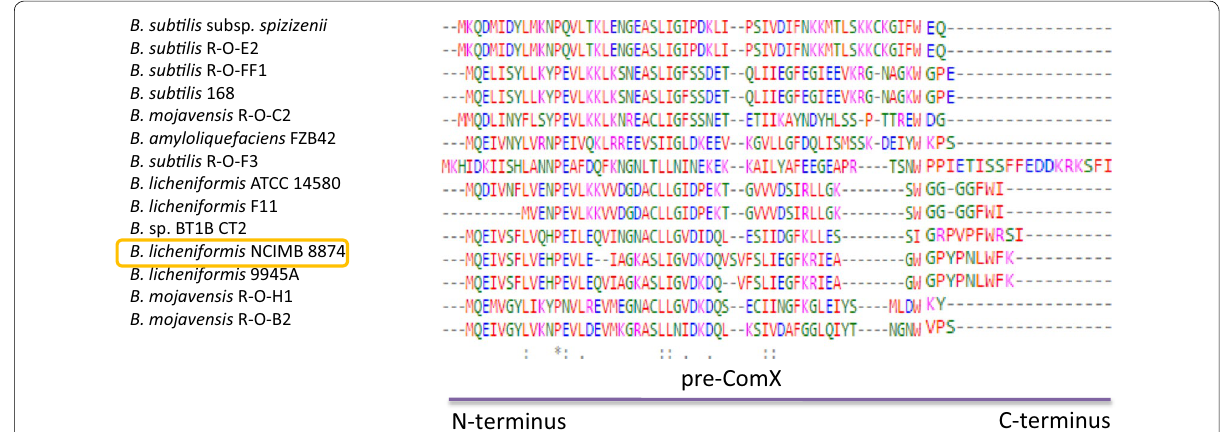
Fig. 1 The amino acid sequence alignments of ComX precursor proteins across Bacilli listed in Table 2. Conservation appears restricted to the N-terminal protein ends. In contrast, high diversity in the C-terminus marks divergent within the pheromone-forming region